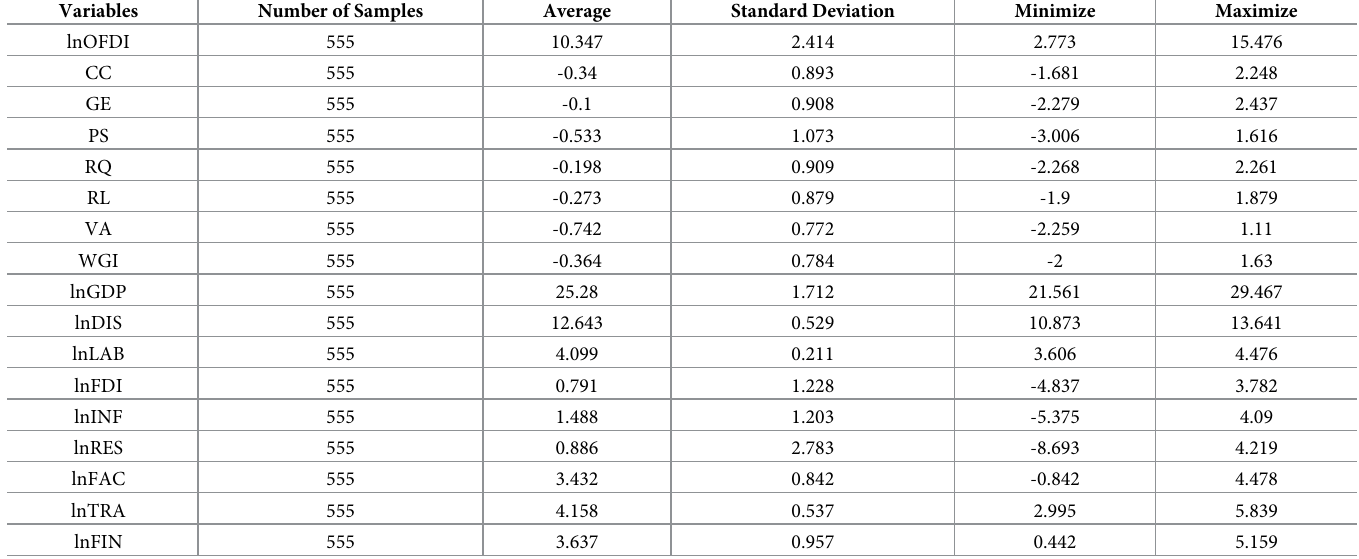
Table 2. Descriptive statistics of the